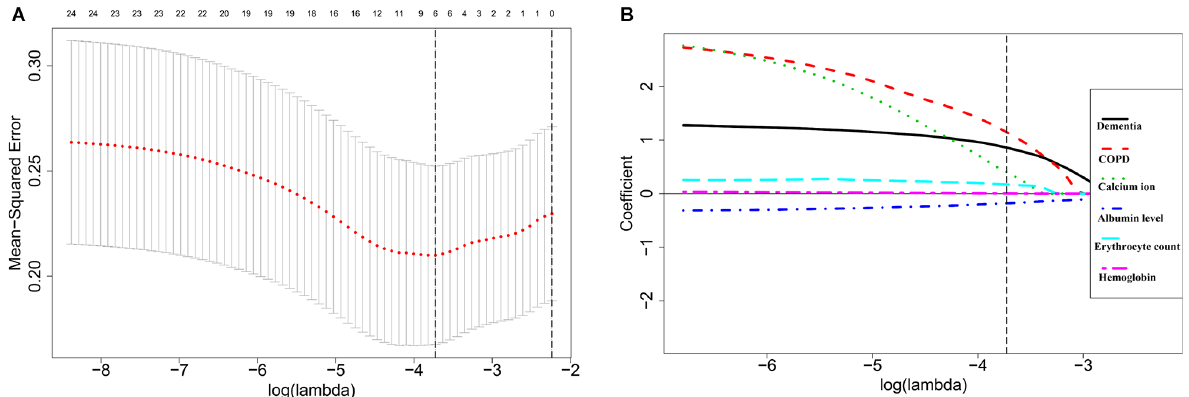
study (14.3%; Zhang et al., 2019) and Zhao’s study (12.2%; Zhao et al., 2021), but lower than Wang’s study (19.12%;